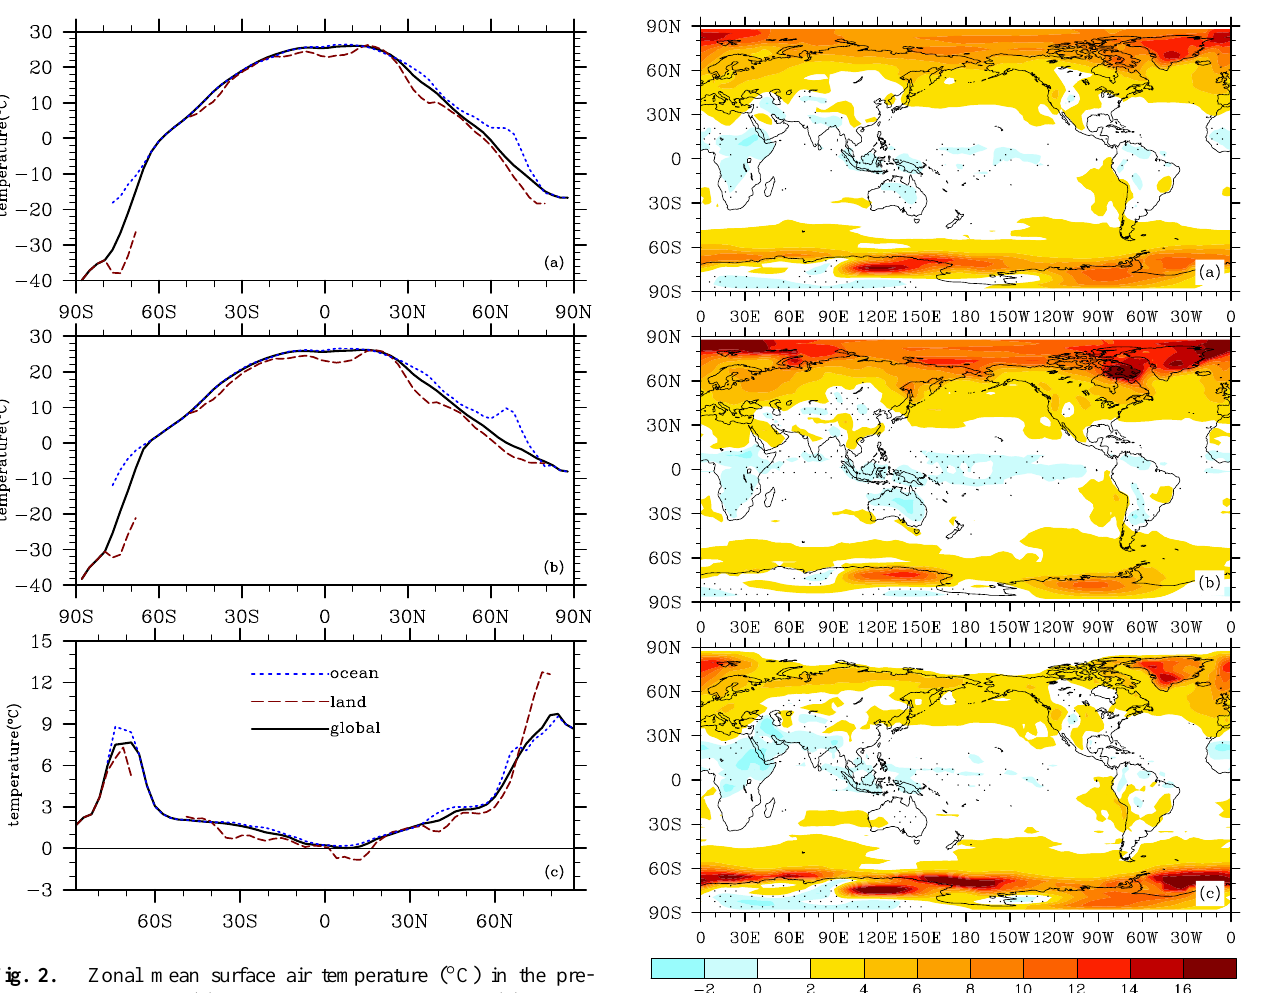
Fig. 2. Zonal mean surface air temperature ( ◦ C) in the pre- industrial experiment (a) , the mid-Pliocene experiment (b) and the anomalies between the mid-Pliocene and pre-industrial (c) .